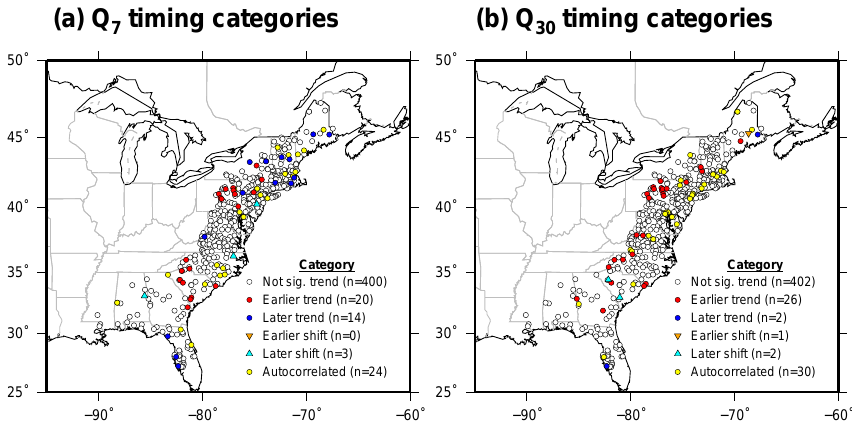
Figure 9. Categorization of nonstationarity of sites for timing of (a) Q7 and (b) Q30.